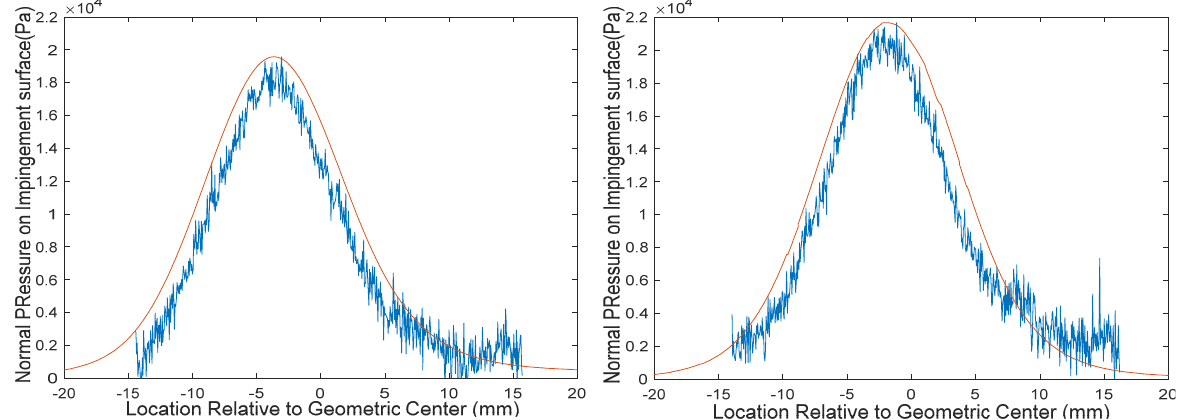
Figure 2. Normal pressure profiles from CFD (red) and pressure-sensitive paint (blue) experiments for h = 30 mm, d = 1 mm, NPR = 1.0 with the impingement angle of 30 degrees ( left ) and 15 degrees ( right ), as shown originally in Fillingham et al. [24].